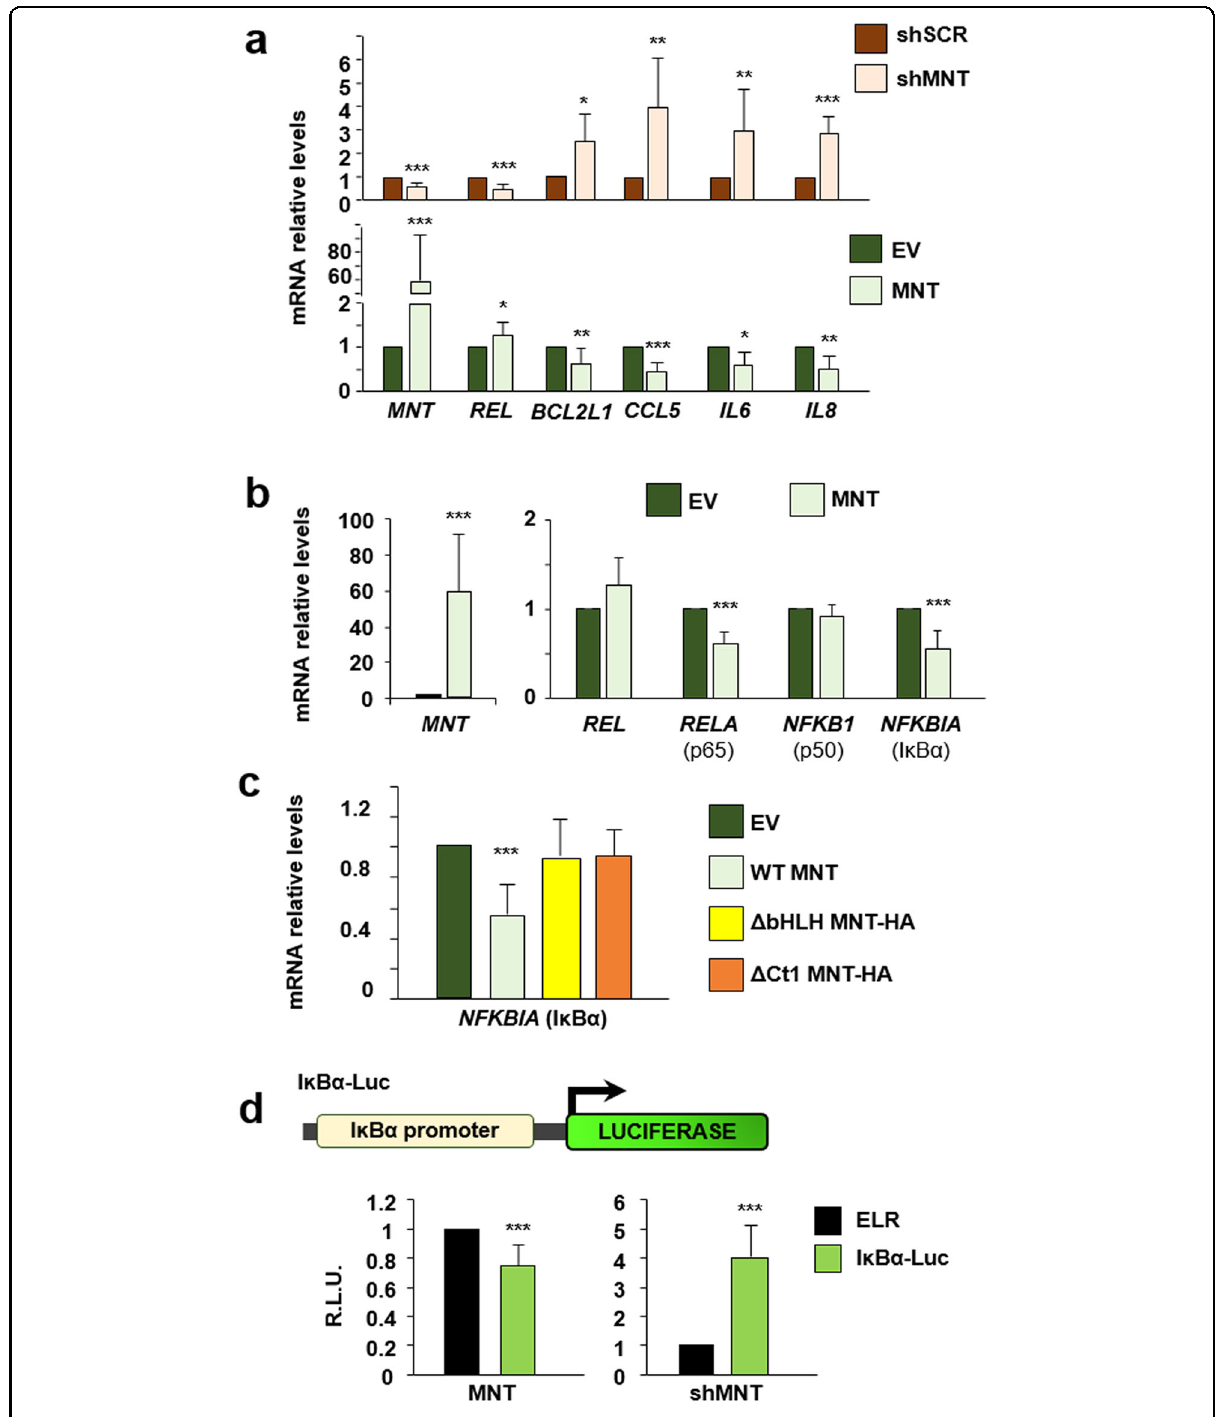
Fig. 5 (See legend on next